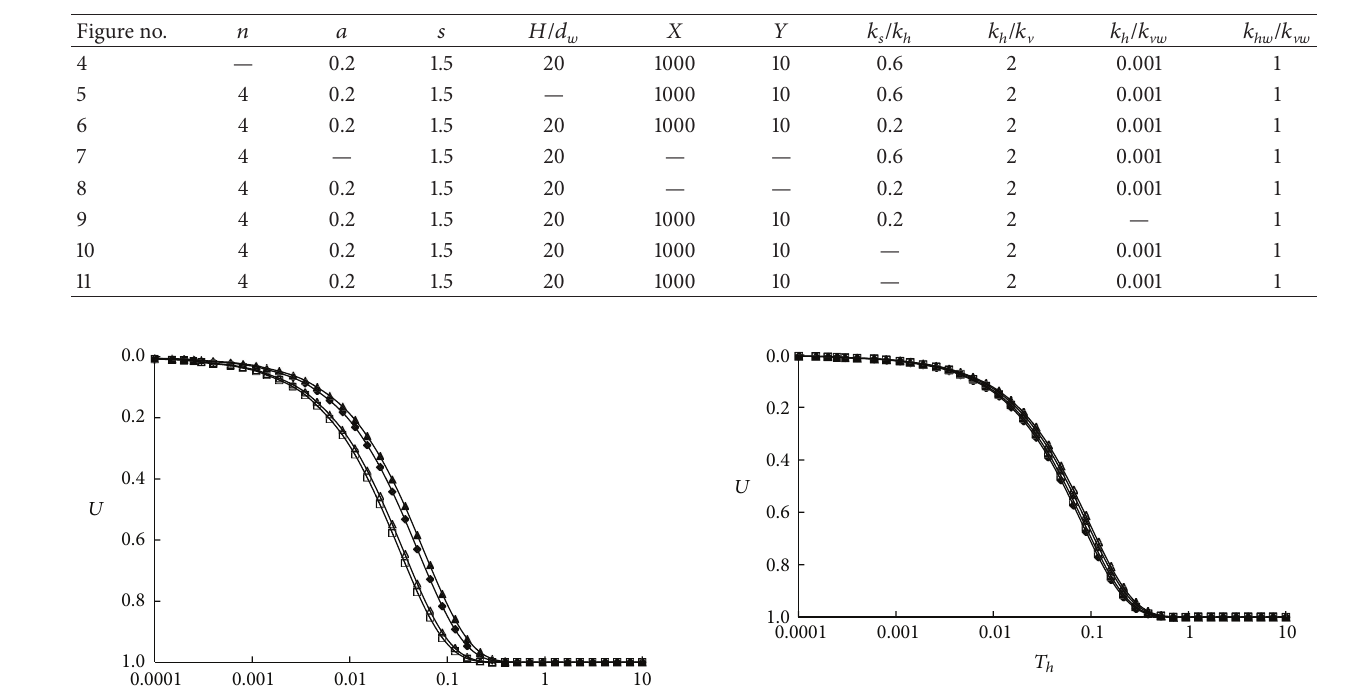
Table 1: Parameters used for calculation ( 𝐼 ).